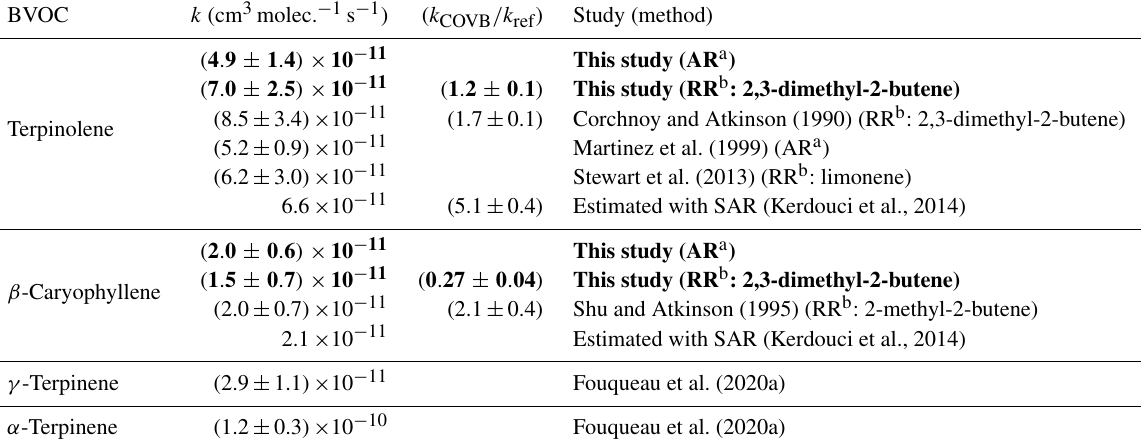
a Absolute rate determination. b Relative rate